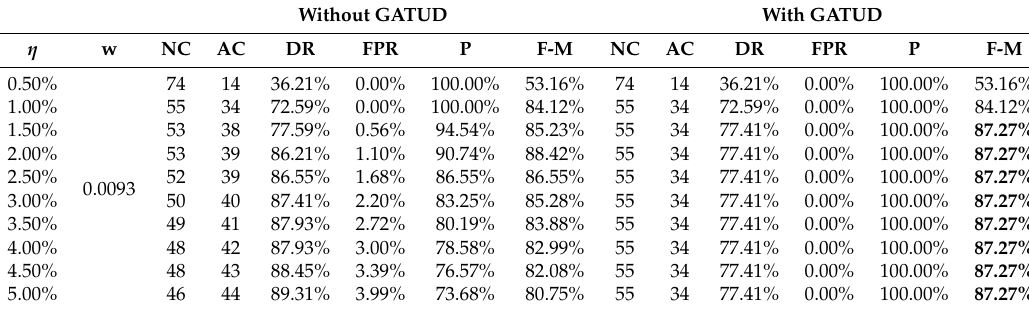
Table 15. The detection accuracy of the proximity-detection rules that have been extracted with/without the integration of GATUD on in the separation process MIRD. Without GATUD With GATUD